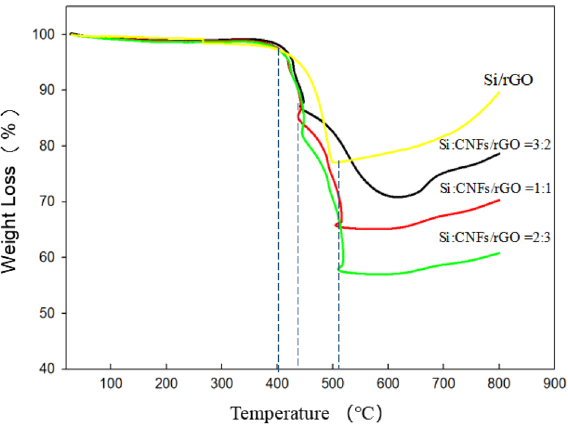
Figure 6. TGA curves of the Si/rGO, Si:CNF/rGO = 3:2, Si:CNF/rGO = 1:1, and Si:CNF/rGO = 2:3 samples.